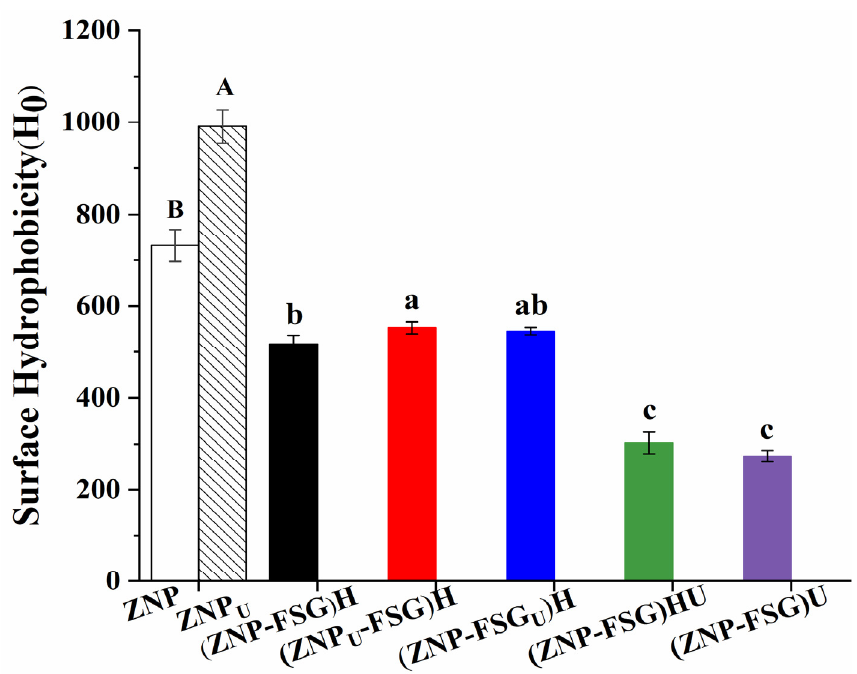
Figure 5. Surface Hydrophobicity (H 0 ) of ZNP-FSG complexes subjected to various ultrasound and homogenization treatments.